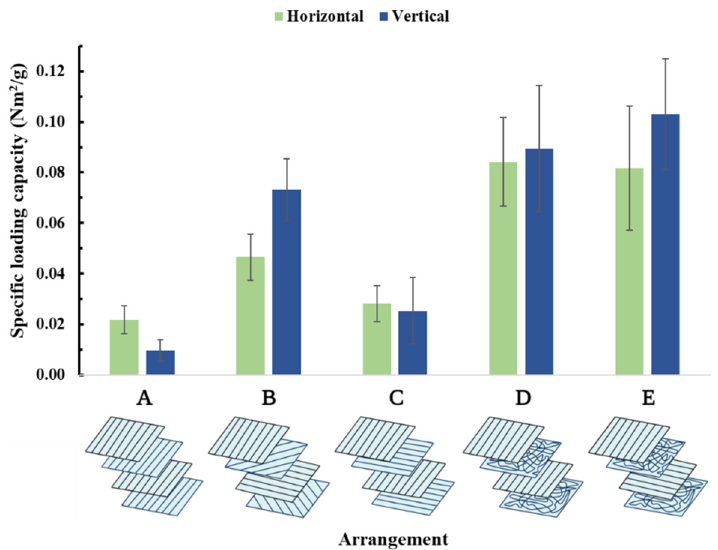
Figure 13. Specific loading capacities of the sutured multilayer membranes.